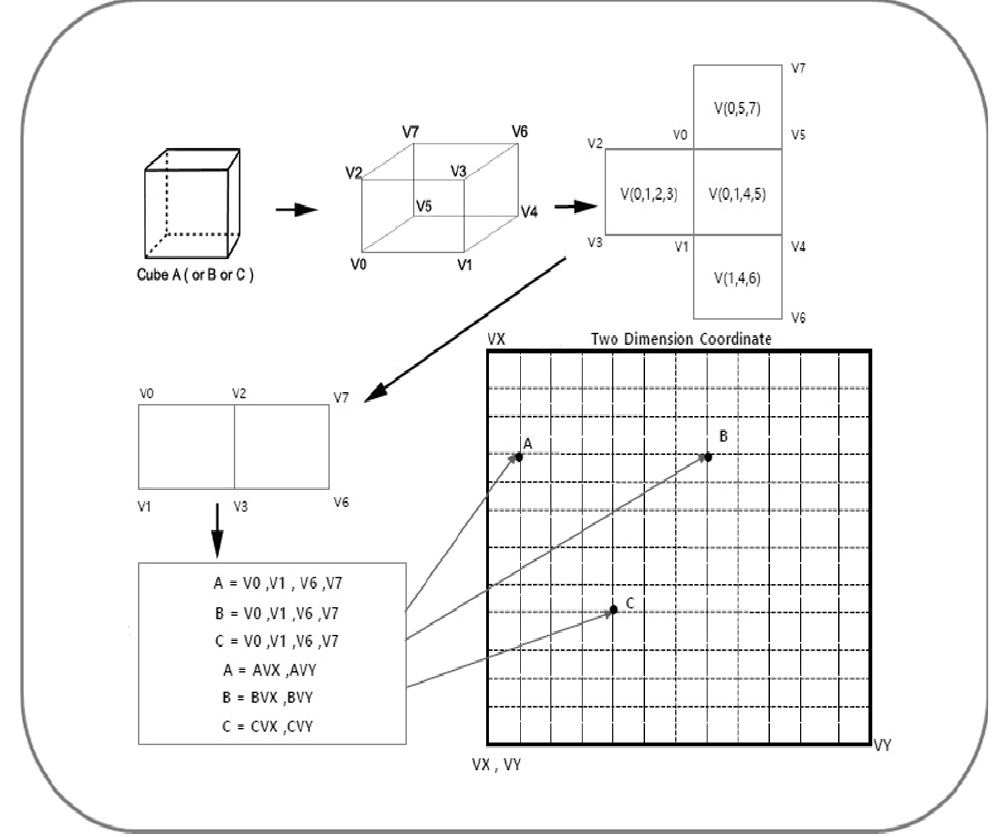
Figure 2. Converting a 3D cube into 2D values.